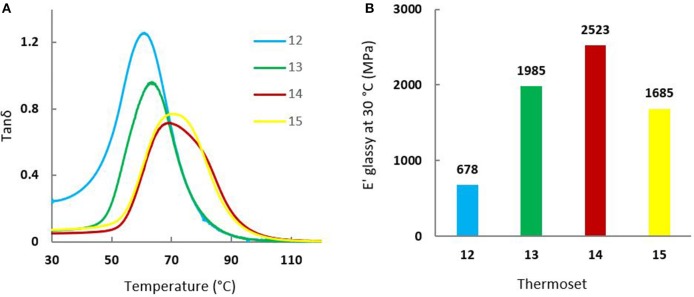
(A) Tan δ curves of (blue) 12, (green) 13, (red) 14, and (yellow) 15 thermosets; (B) Storage modulus (E'glassy) at 30°C of (blue) 12, (green) 13, (red) 14, and (yellow) 15 thermosets.